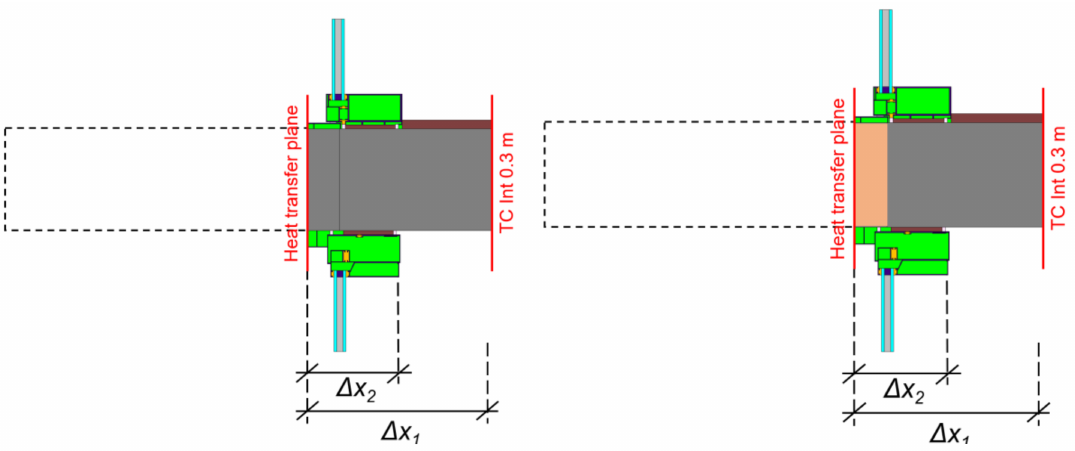
Figure 6. Vertical sections through the control (left) and thermally-broken (right) balcony